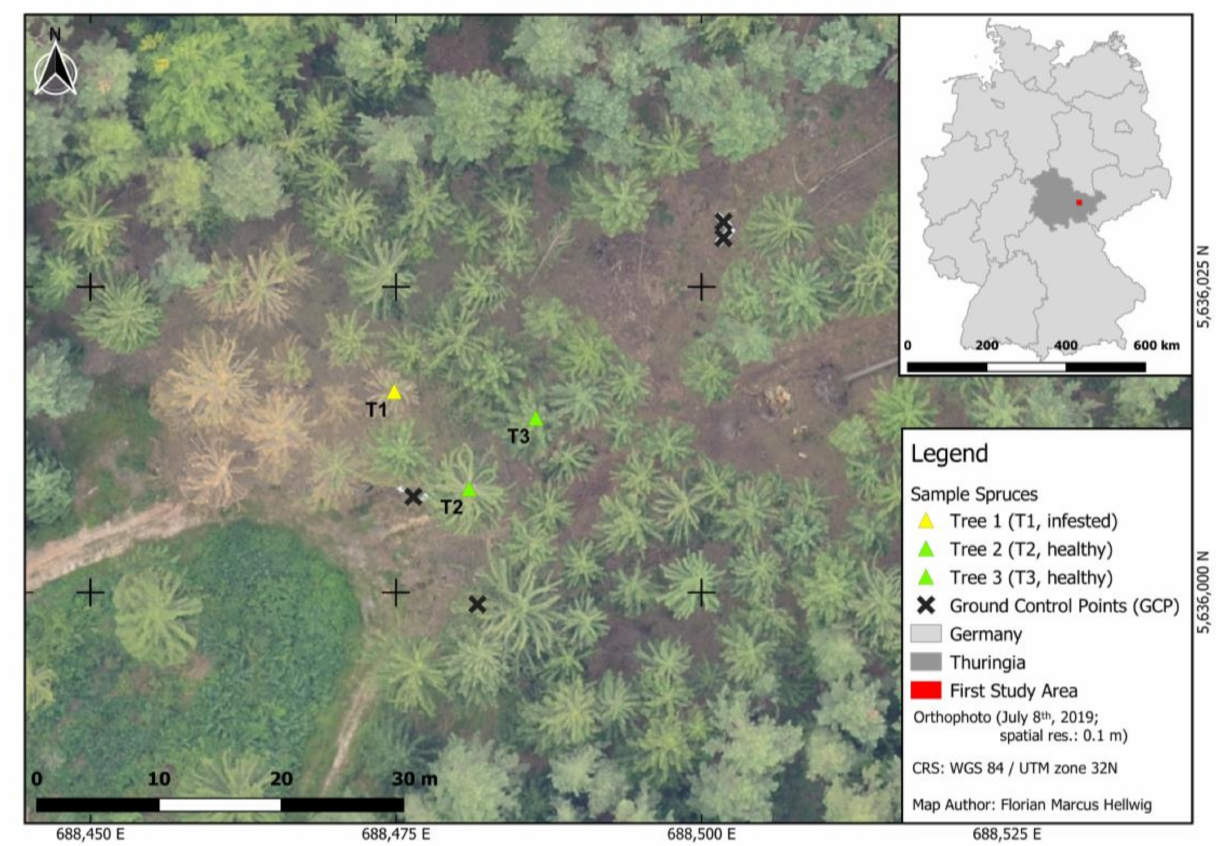
Figure 1. First study area with location of sample spruces within a mixed deciduous and spruce forest (8 July 2019). To the west of the infested Tree 1 (“green attack”), there are infested trees with a “brown crown”, visible from the brown discoloration of the tree crown. Infestation stages of the spruces are shown in Table